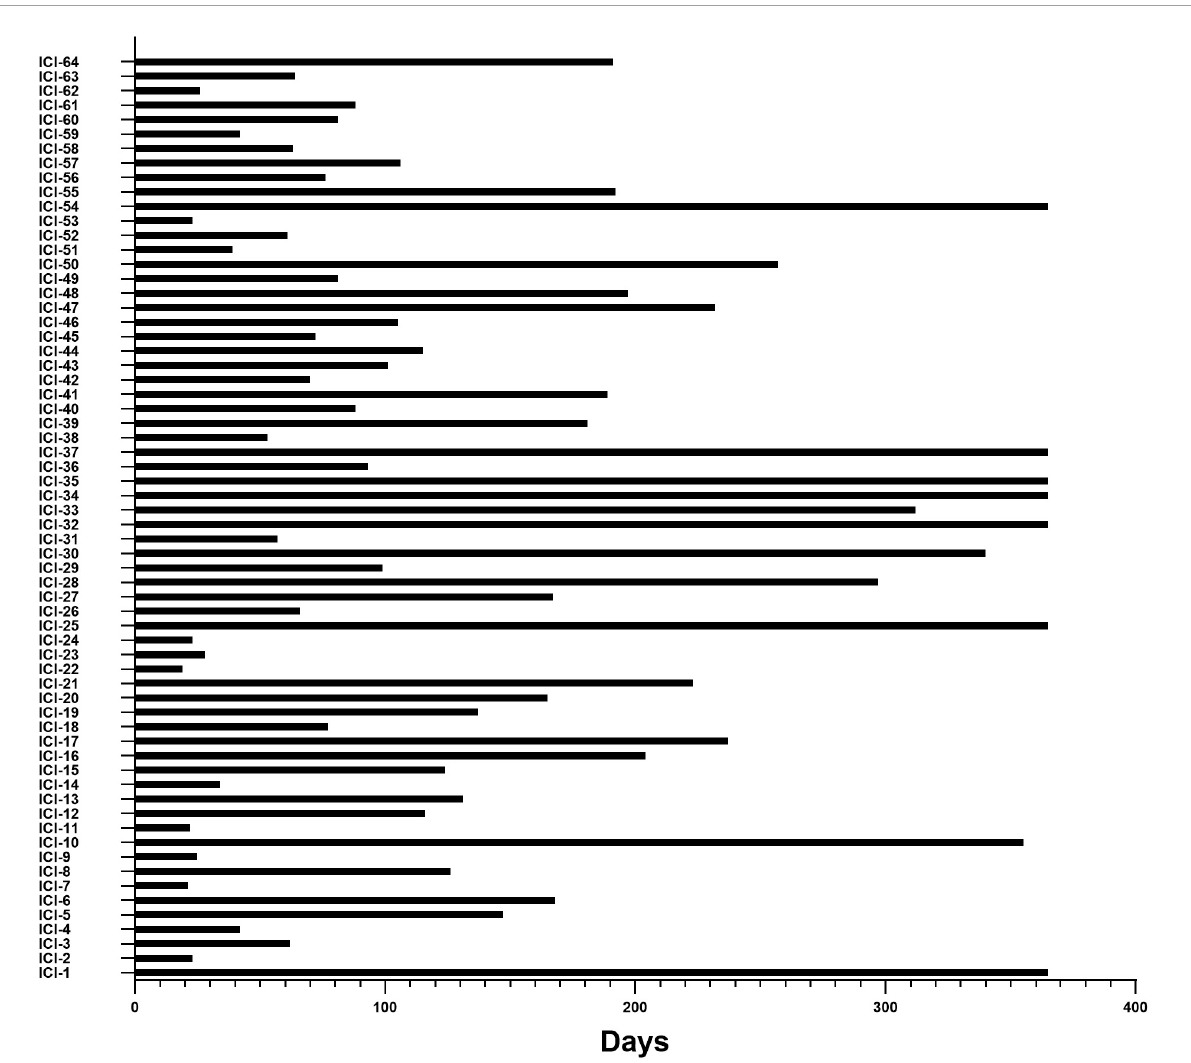
FIGURE3 Time from initiation of ICI therapies to the occurrence of CAEs. X-axis, time (days) from cancer treatment with ICIs to the onset of CAE; Y-axis, the number of individual subjects with CAE in 64 of the 495 ICI-treated cohort patients in the study.